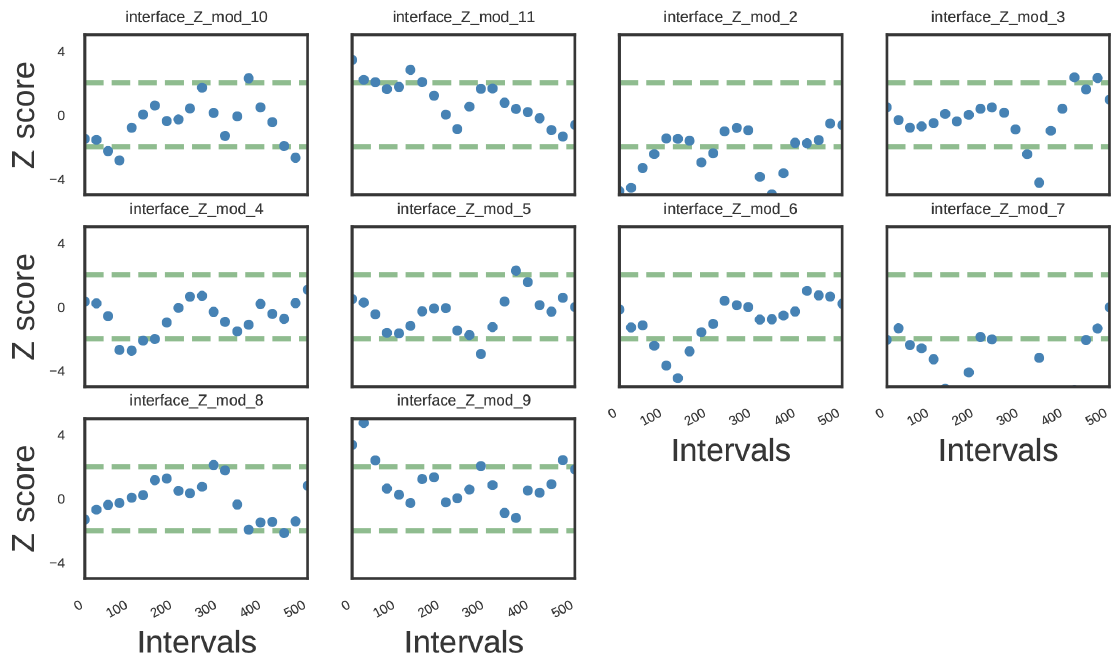
Figure E1. Geweke values of the parameters belonging to the inference of all likelihoods. Every point represents the mean of separated intervals of the chain. If interval A and interval B belong to the same distribution, most of the Z score should fall within 2 SD.